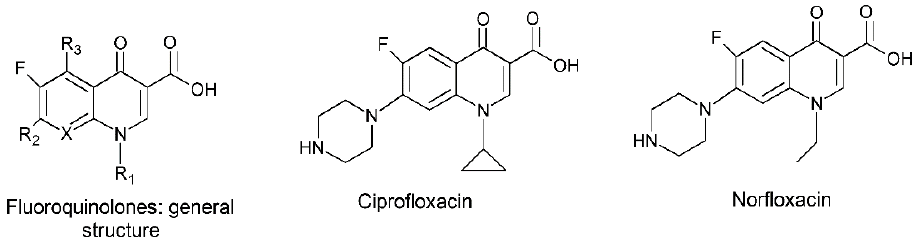
Figure 13. Some drugs easily encapsulated in polyphosphazenes bearing amino acid esters as side groups.